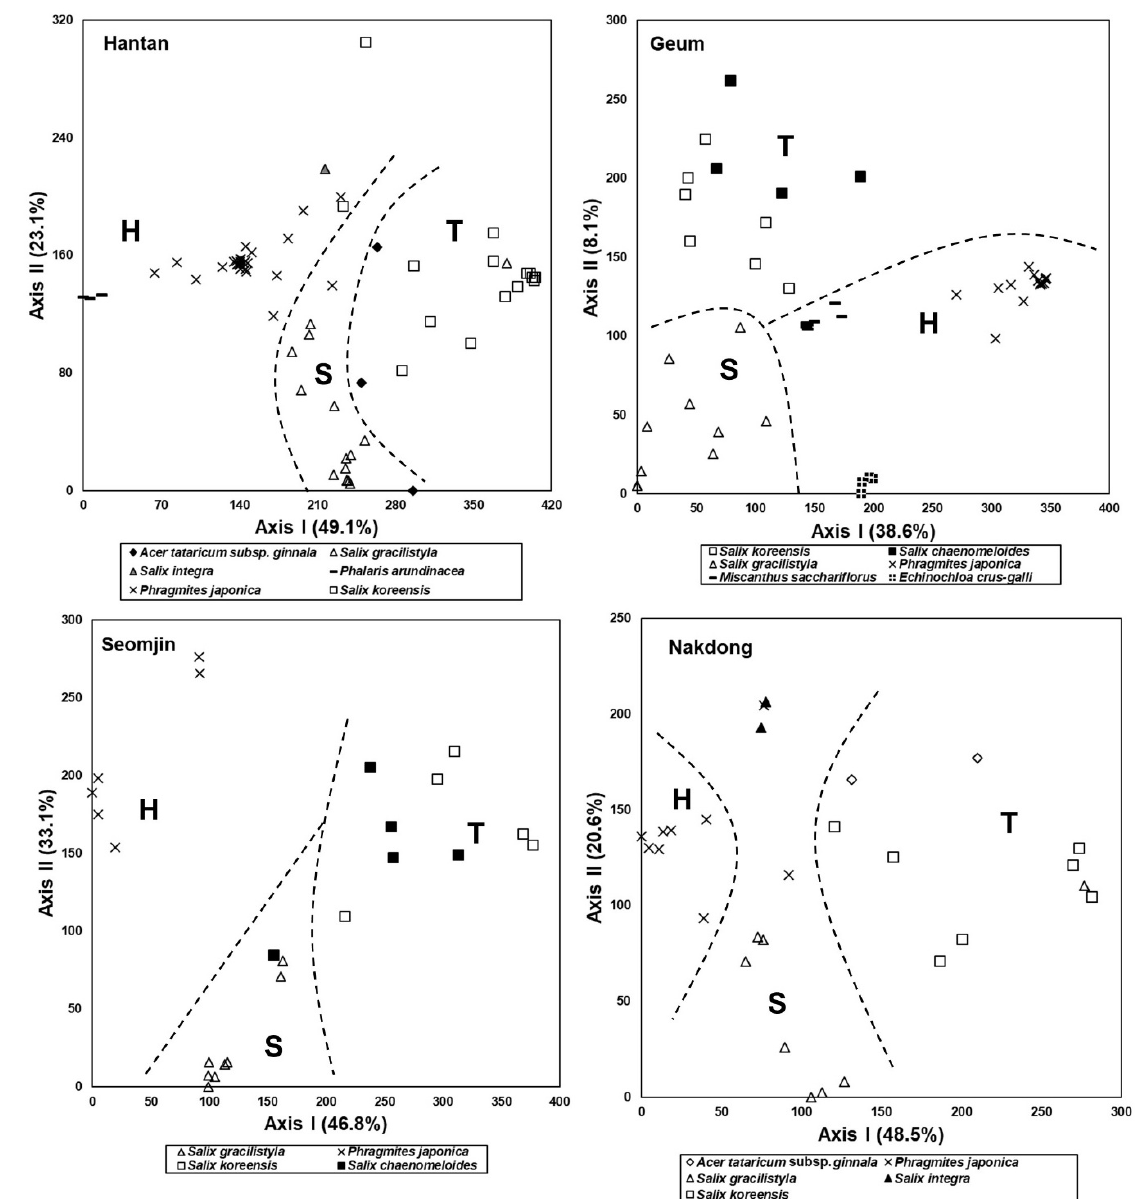
Figure 6. DCA ordination of stands based on vegetation data collected from the riparian zones of four rivers in South Korea: Hantan River, Geum River, Seomjin River, and Nakdong River. H: herbaceous plant dominated-stands, S: shrub-dominated stands, T: tree-dominated stands